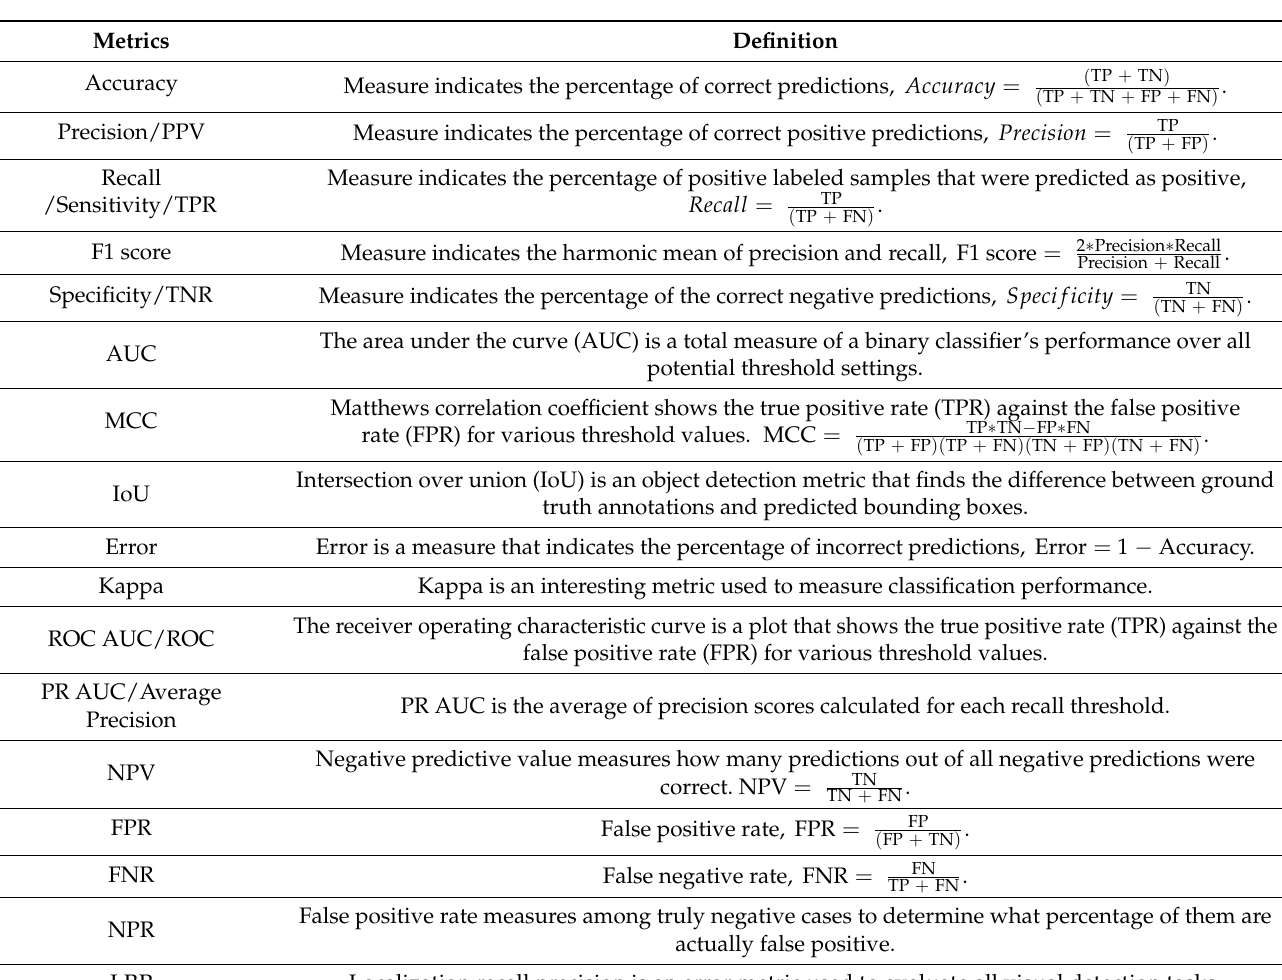
Table 3. Summary of benchmarks metrics used in the relevant publications in this